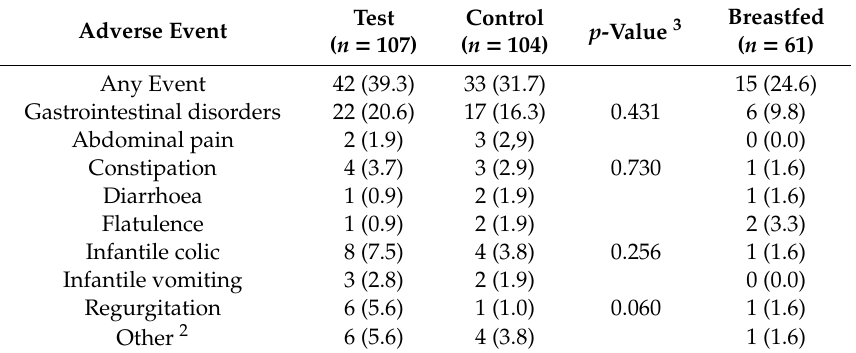
Table 5. Number and percentage of infants with any event and at least one adverse event in the system organ class of gastrointestinal disorder 1